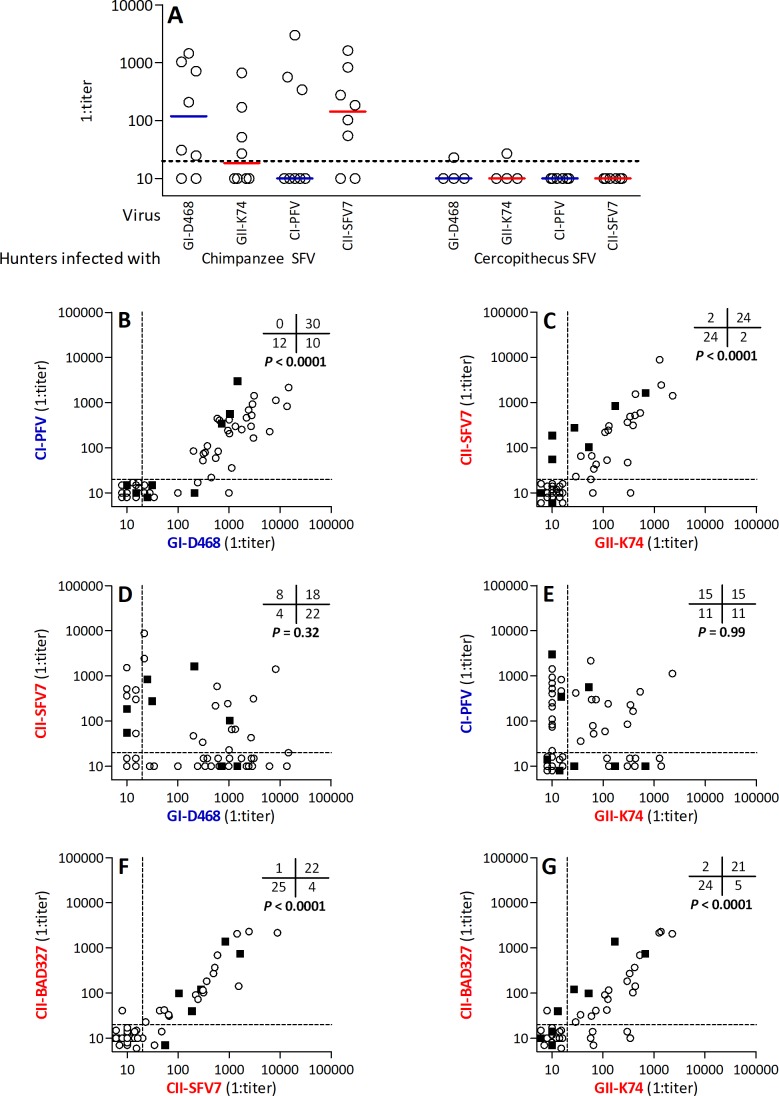
Frequent cross-neutralization of gorilla and chimpanzee SFV belonging to homologous genotypes.Neutralization assays were performed against four viral strains with plasma samples from individuals infected with three SFV species (chimpanzee, gorilla, and cercopithecus). A. Neutralization titers against four strains (GI-D468, GII-K74, CI-PFV, CII-SFV7) are shown for individuals infected with chimpanzee or cercopithecus SFV; bars indicate the median values. B to G: Neutralization titers against pairs of strains are presented with symbols corresponding to the infecting SFV species (open circles: gorilla SFV; filled squares: chimpanzee SFV). The dashed lines indicate neutralization detection thresholds (1:20). Tables indicate the number of individuals with and without neutralizing antibodies against each of the two strains, with P values from Fisher’s exact test.